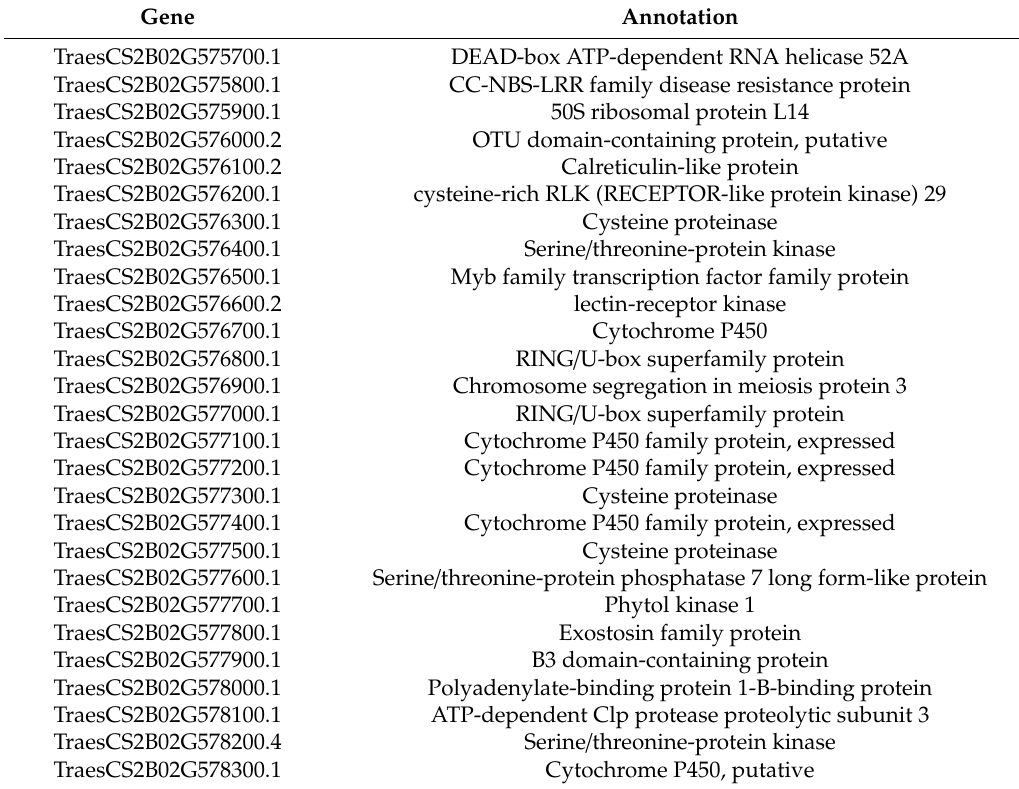
Table 2. Gene models between the two flanking markers AX-111643885 and AX-111128667 based on the International Wheat Genome Consortium (IWGSC) RefSeq v1.1